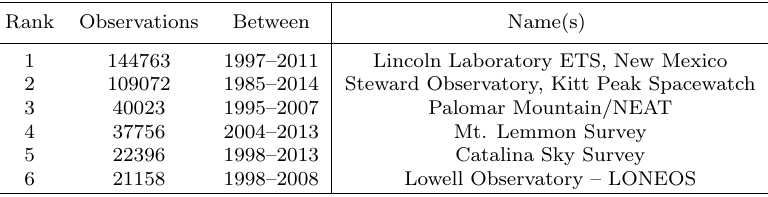
Table 2. Minor Planet Discoverers, as of June 3,